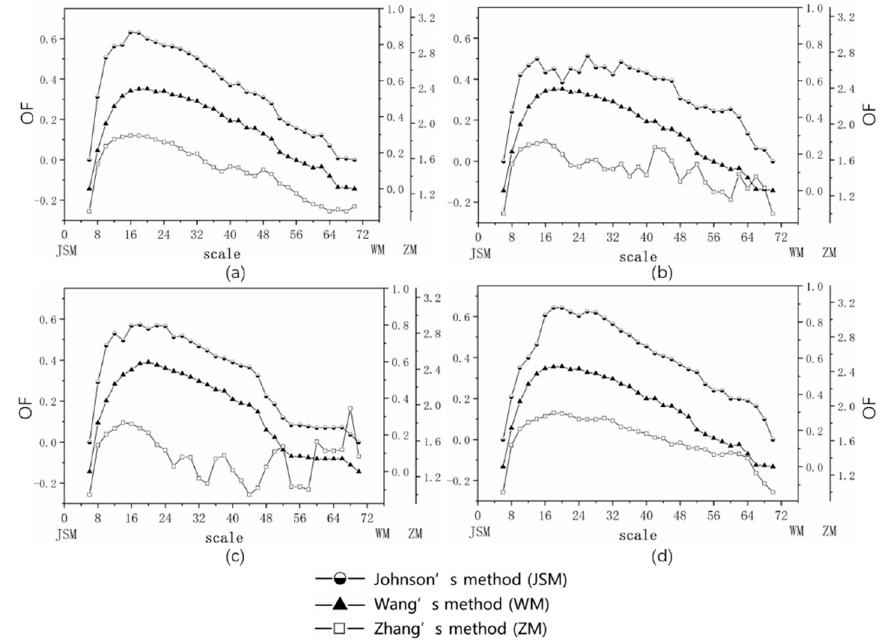
Figure 3. Segmentation optimization results with a scale of 6-70 for the four study areas: ( a ) P1, ( b ) P2, ( c ) P3, and ( d ) P4.